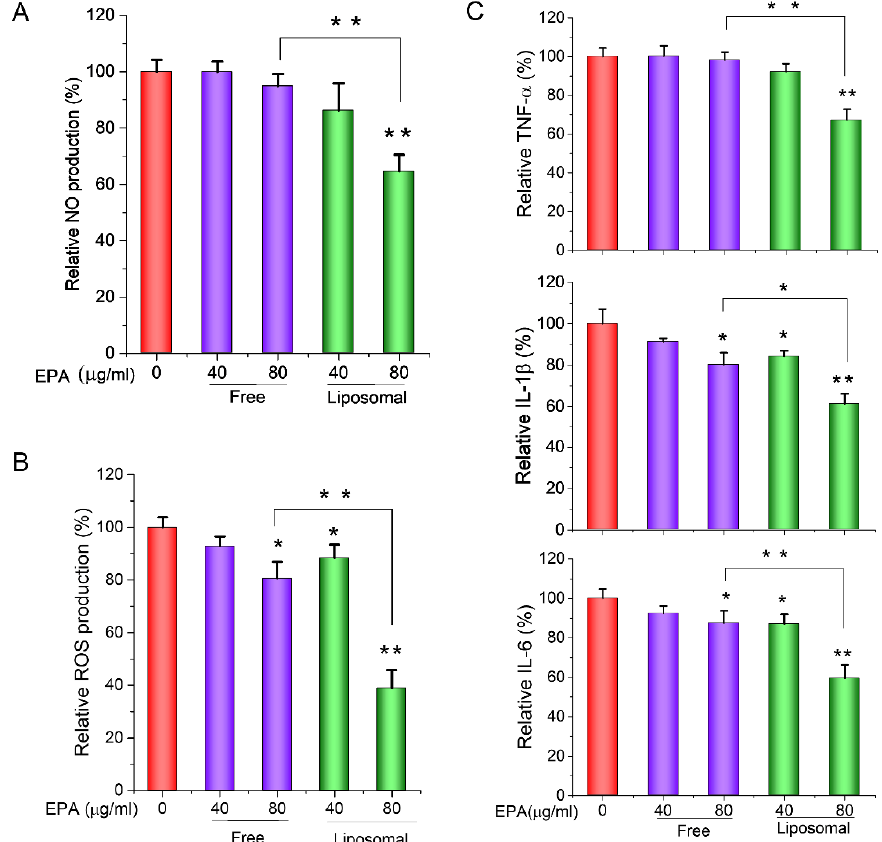
Figure 5. The inhibition of production of NO, ROS, and cytokines by EPA-liposomes. The differen- tiated HL60 cells were treated with free EPA or EPA-liposomes at the indicated concentrations in the presence of LPS (100 ng/mL) for 24 h, and the NO contents ( A ) in the cell culture media were determined by the Griess agent. ( B ) The ROS levels in the cells were determined by the ROS detection kit. ( C ) The cytokine levels in the cell culture medium were determined by the ELISA kit following the guidance of the manual. The data are expressed as means ± SD. * p < 0.05, ** p < 0.01, n = 3.